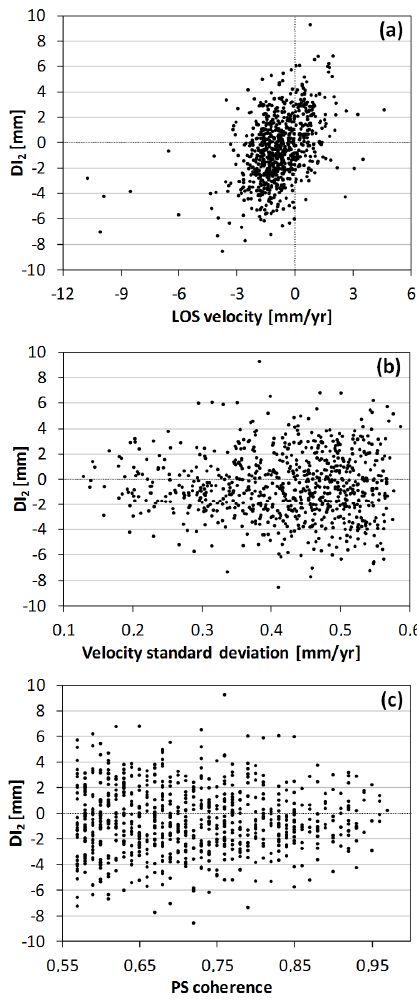
Fig. 9. Comparison of Deviation Index DI 1 with LOS velocity (a) , its standard deviation (b) and PS coherence (c) , for the PS time Figure 9. Comparison of Deviation Index DI 1 with LOS velocity (a), its standard deviation (b) and 652 series of the test area of St. Barbara. Figure 10. Comparison of Deviation Index DI PS coherence (c), for the PS time series of the test area of St. Barbara. 653